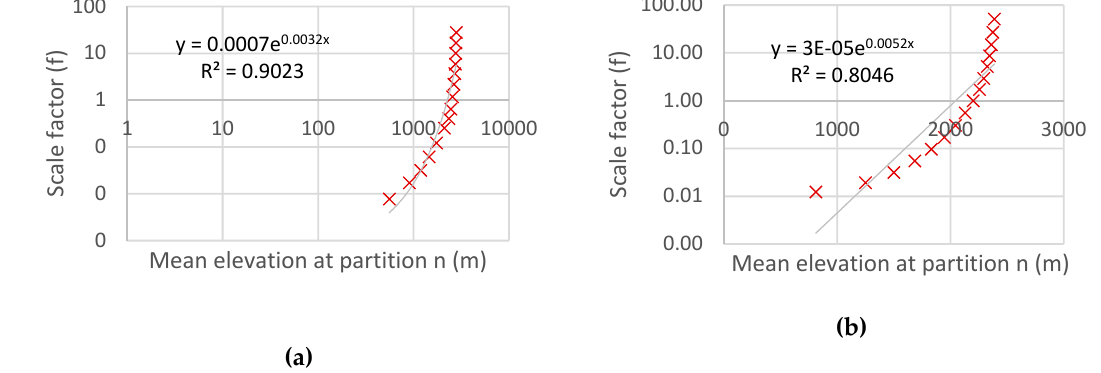
Figure 11. Indicative log-log plots of optimal scale factor vs. mean elevation for the two studied river basins; ( a ) Pinios and ( b ) Acheloos.